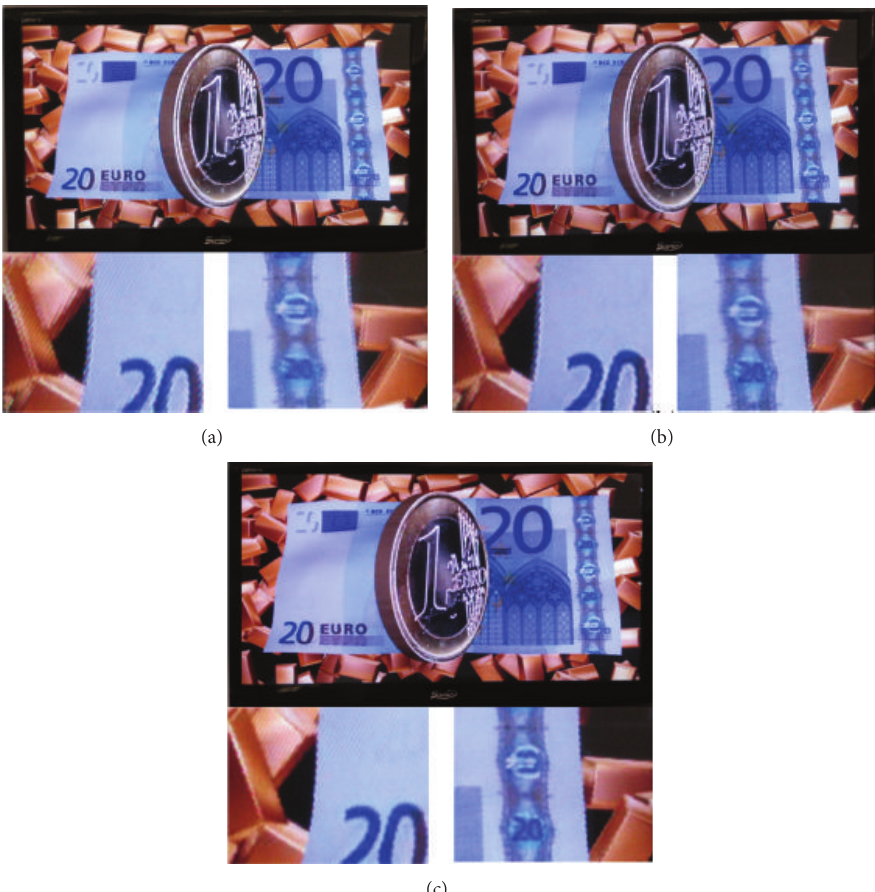
Figure 4: Photos of a scene “Euro” taken at the fourth optimal viewing position. (a) Result before correction. (b) Result by method given in [11]. (c) Result by our